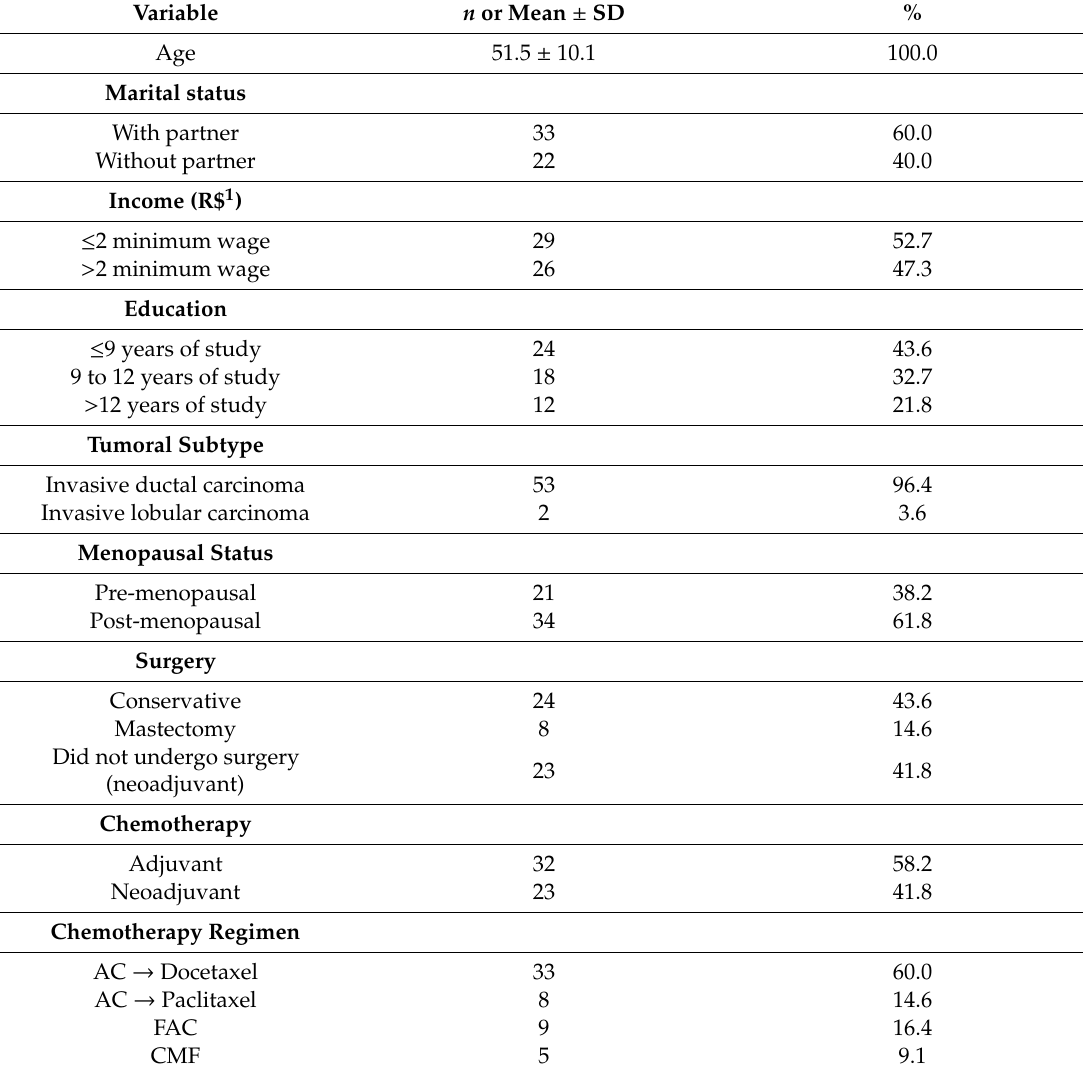
Table 1. Clinical, therapeutic, and socio-demographic characteristics of women with breast cancer in chemotherapy seen at Clinics Hospital of the Federal University of Uberlandia, Minas Gerais, Brazil, 2014–2015 ( n =